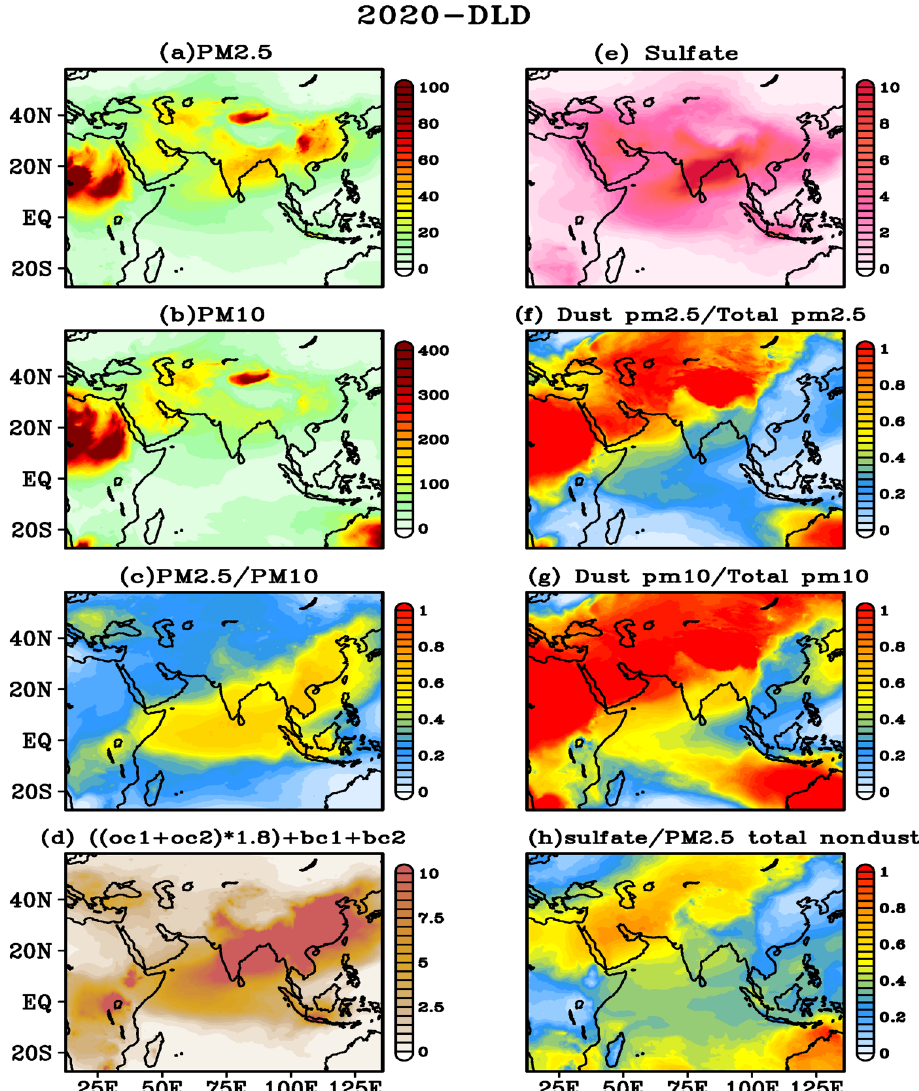
Figure 7. Spatial distribution of ( a ) PM 2.5 , ( b ) PM 10 , ( c ) ratio between PM 2.5 and PM 10 , ( d ) organic matter and black carbon ((OC hyrdrophobic + OC hydrophilic) × OC mass fraction (1.8) + BC hyrdrophobic + BC hydrophilic), ( e ) sulfate, ( f ) ratio between dust PM 2.5 and total PM 2.5 , (g) ratio between dust PM 10 and total PM 10 , and ( h ) ratio between sulfate and PM 2.5 total non-dust obtained during DLD period based on WRF-Chem simulations for India and adjacent regions. All units are in μg m −3 except ratios. The figures are plotted using GrADS V2.2.1 software (http:// cola. gmu. edu/